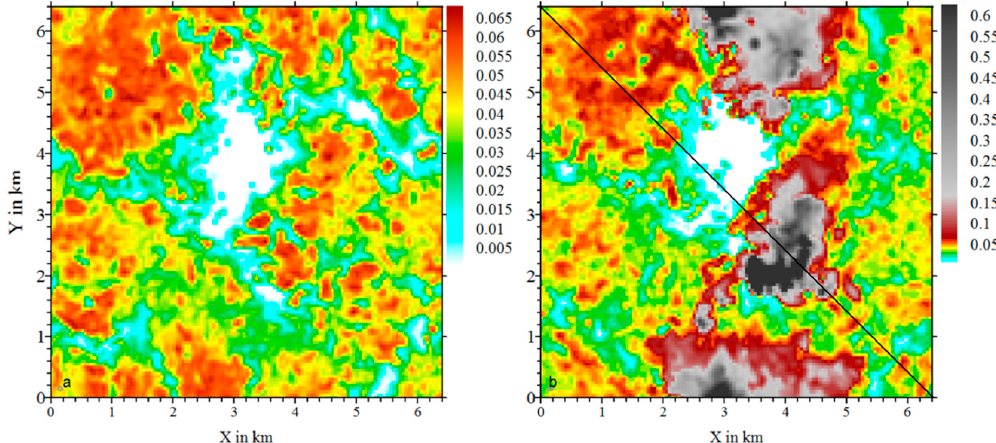
Figure 9. Horizontal cross section of the aerosol mass in drops in µg m − 3 near cloud top at 1520 m altitude after 260 min of simulation; ( a ) without the presence of the plume; ( b ) with the plume; the black line indicates the location of the vertical cross sections of Figure 10.